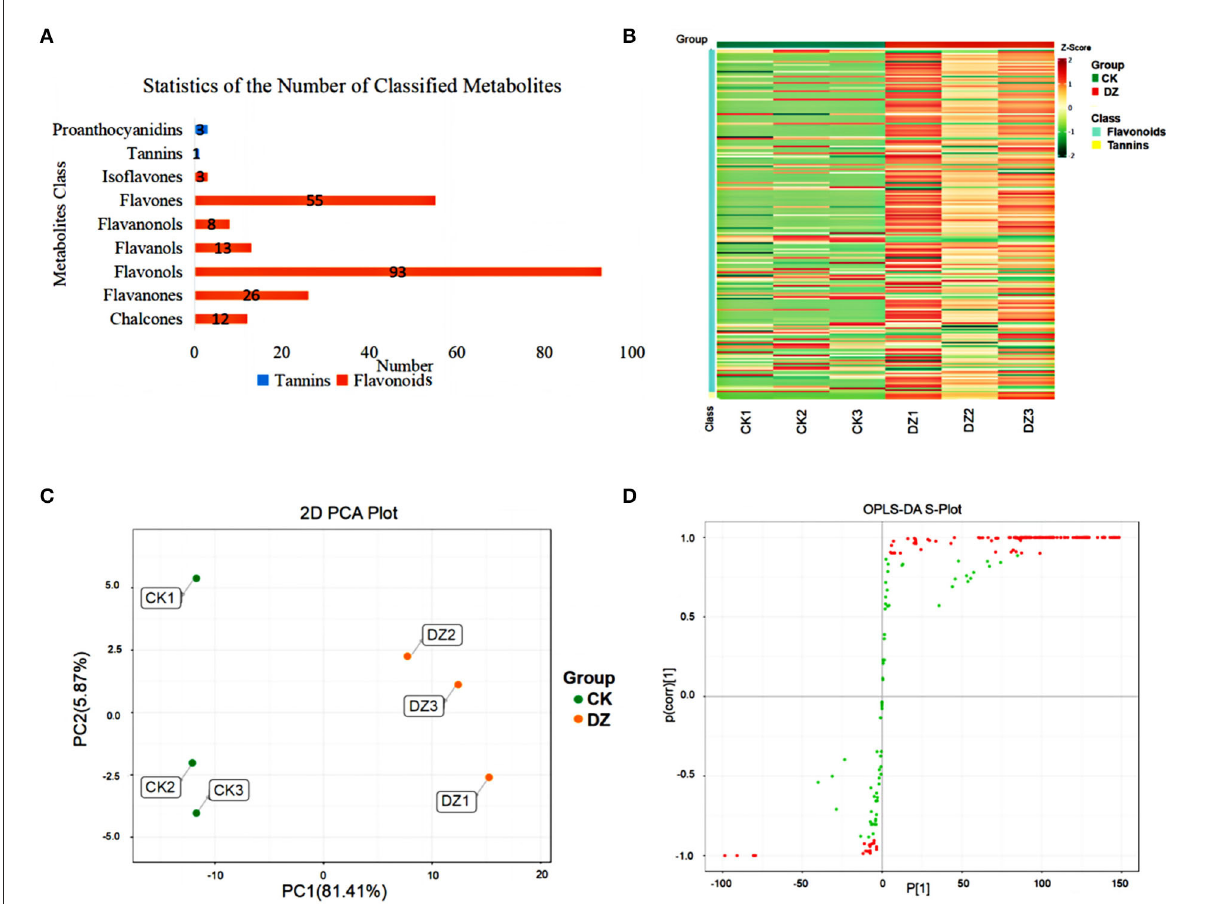
FIGURE2 Metabolites analysis of the traditional sweet rice wine (CK) and new product (DZ). (A) Statistics of the number of classified metabolites; (B) overall sample content map, red represents high content, and green represents low content; (C) PCA of metabolites, and (D) S-plot generated from the OPLS-DA modle for CK vs. DZ. Green and red spots indicate all VMs involved in the model, and red spots suggest the most significant changes and higher contributions to the classification